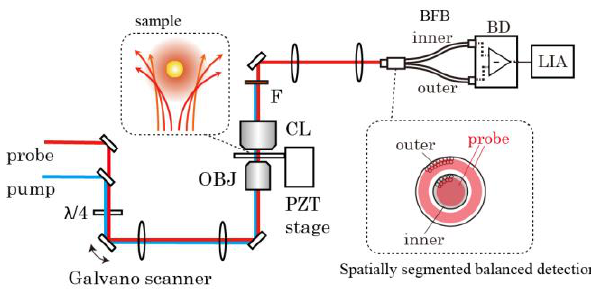
Figure 1. Photothermal microscope setup with spatially segmented balanced detection using a bifurcated fiber bundle (BFB). OBL: objective lens, CL: condenser lens, F: filter, BD: balanced detector, LIA: lock-in amplifier.